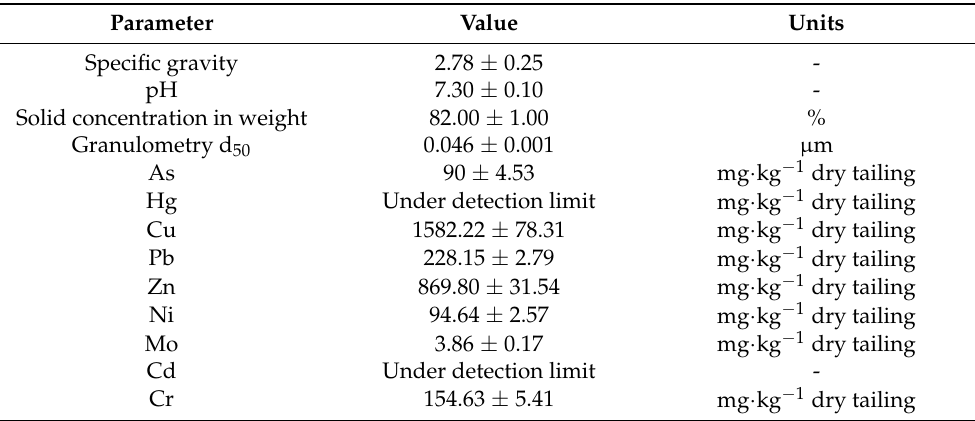
Table 1. Characterization of tailing